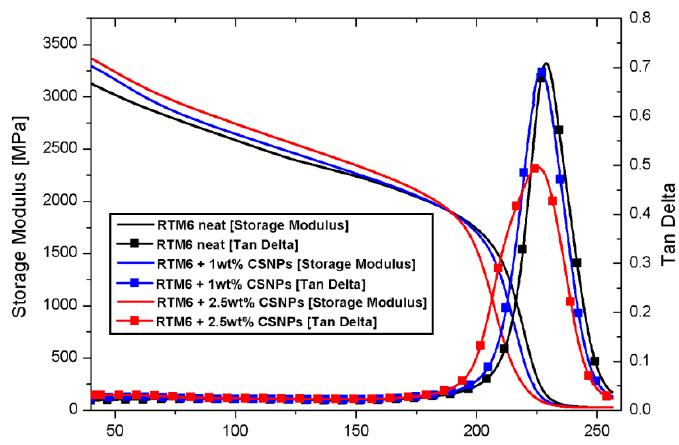
Figure 8. Dynamic mechanical analysis (DMA) curves of neat (black curve), 1 wt% (red), and 2.5 wt% (blue) filled systems.